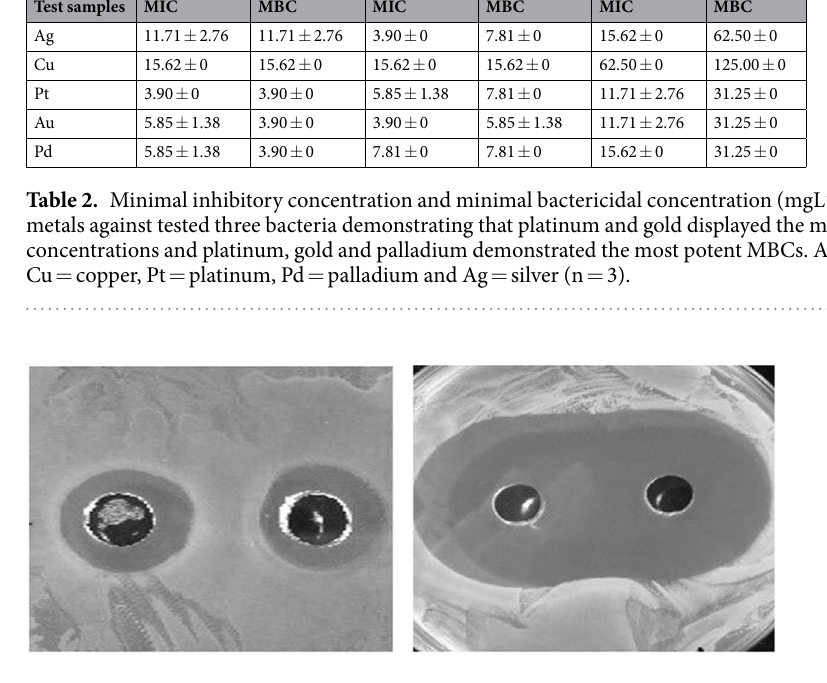
Figure 2. Examples of combined metals used in ZoI to demonstrate the interactions. ( a ) Palladium/platinum against Gram negative bacteria (indifference interaction) and ( b ) gold/palladium against E. faecium (synergy interaction).